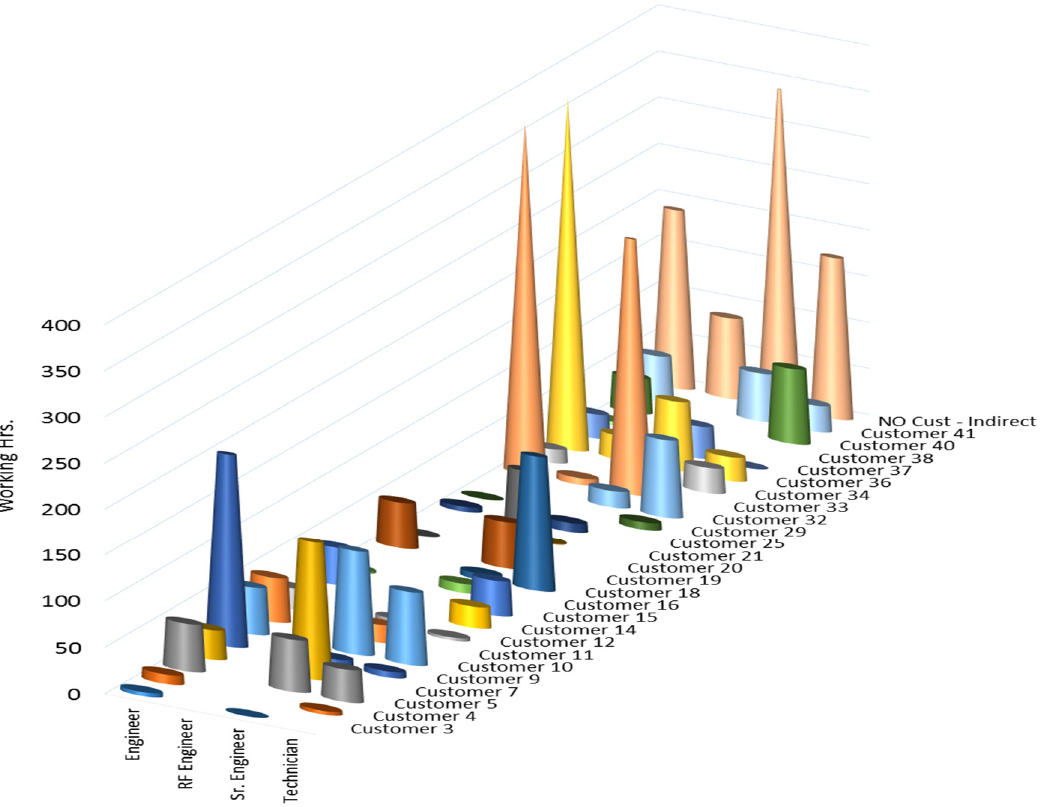
Figure 17. Customer wise operator performance—Q1 2019.